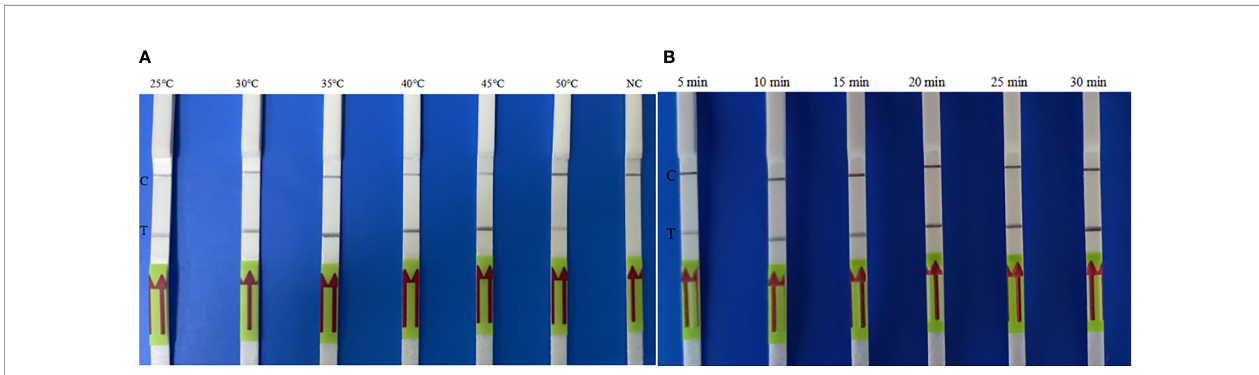
FIGURE 3 | Optimization of the temperature (A) and time (B) for the LF-RPA. (A) gDNA of B . pseudomallei BPC006 (2 ng) was used in each reaction at the indicated temperatures for 10 min; (B) gDNA of B . pseudomallei BPC006 (2 ng) was used in each reaction at 40°C for the indicated time. NC, negative control; C, control line; T, test line. These experiments were repeated three times.